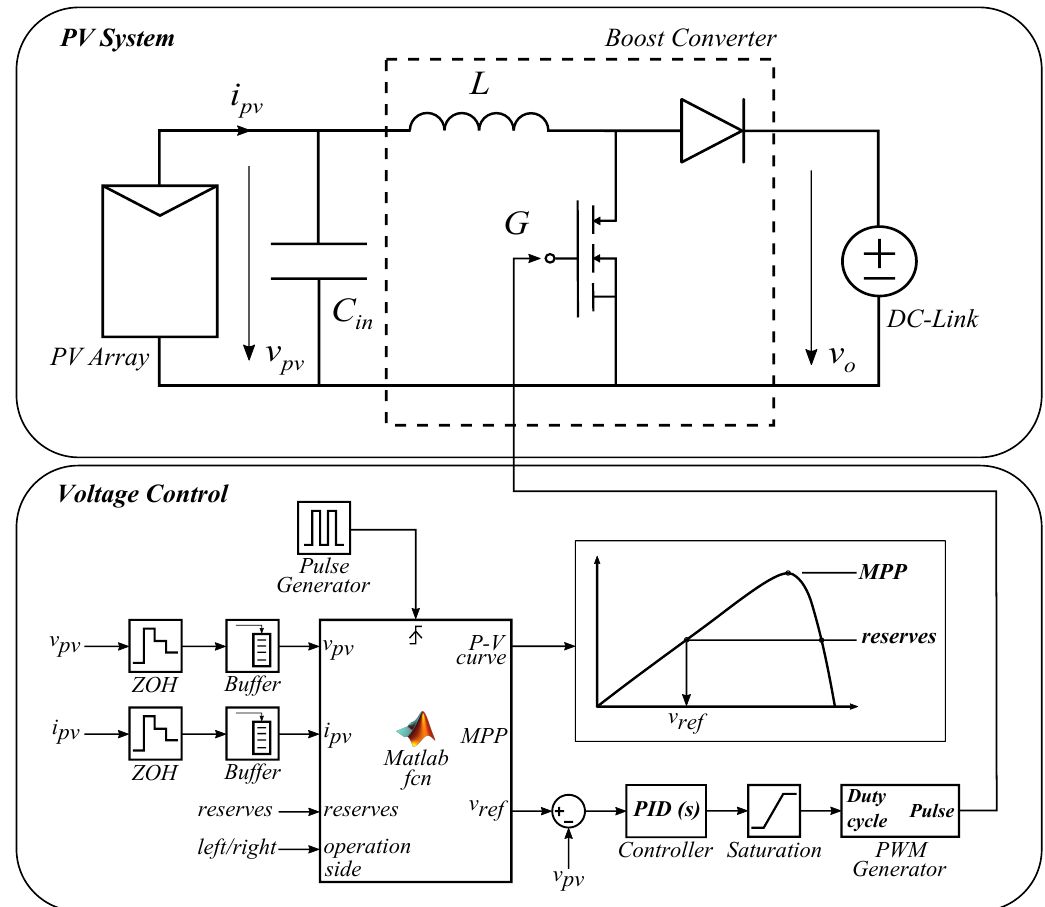
Figure 11. Detailed model of the photovoltaic and the voltage control